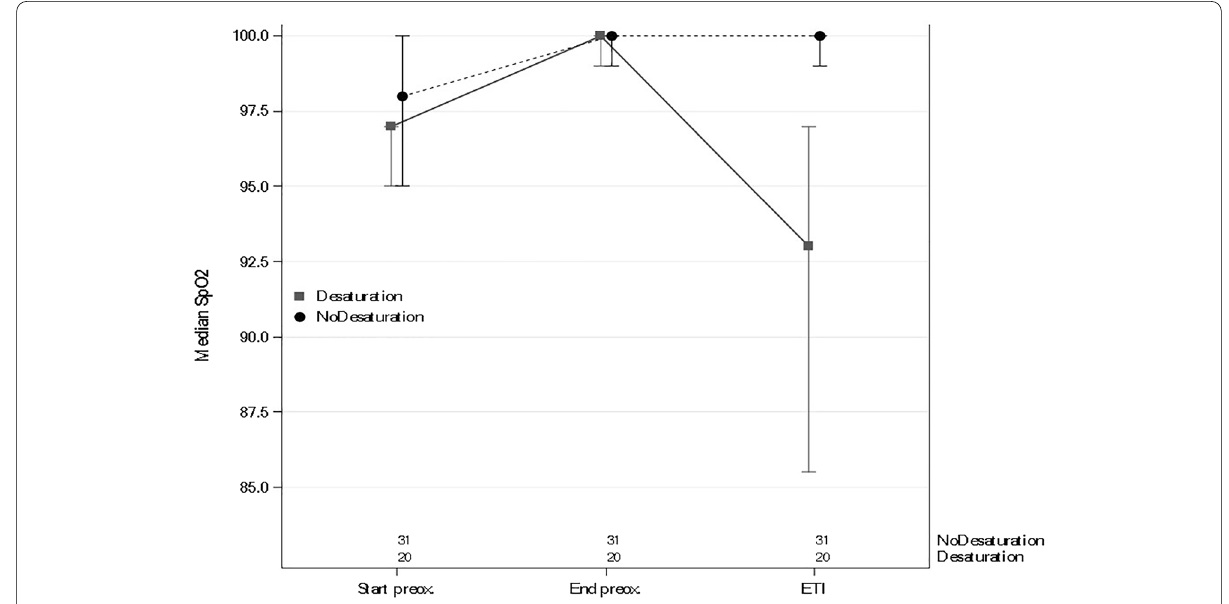
Fig. 1 SpO 2 changes during preoxygenation and endotracheal intubation